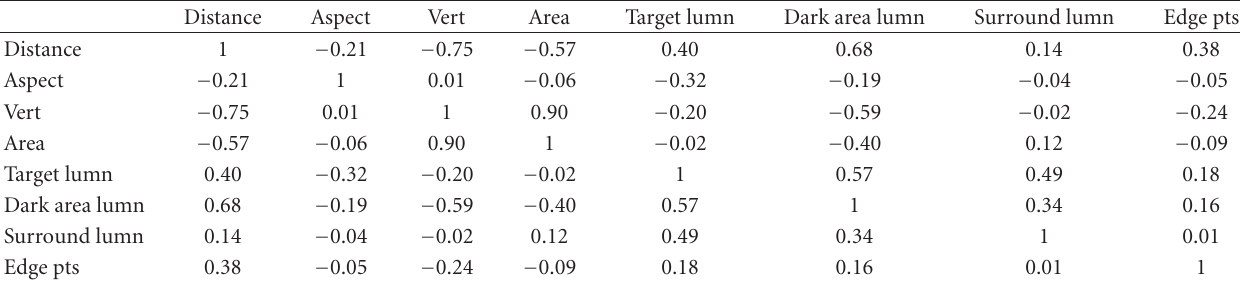
Table 7: MiniTab correlation matrix of pentalevel quantization of